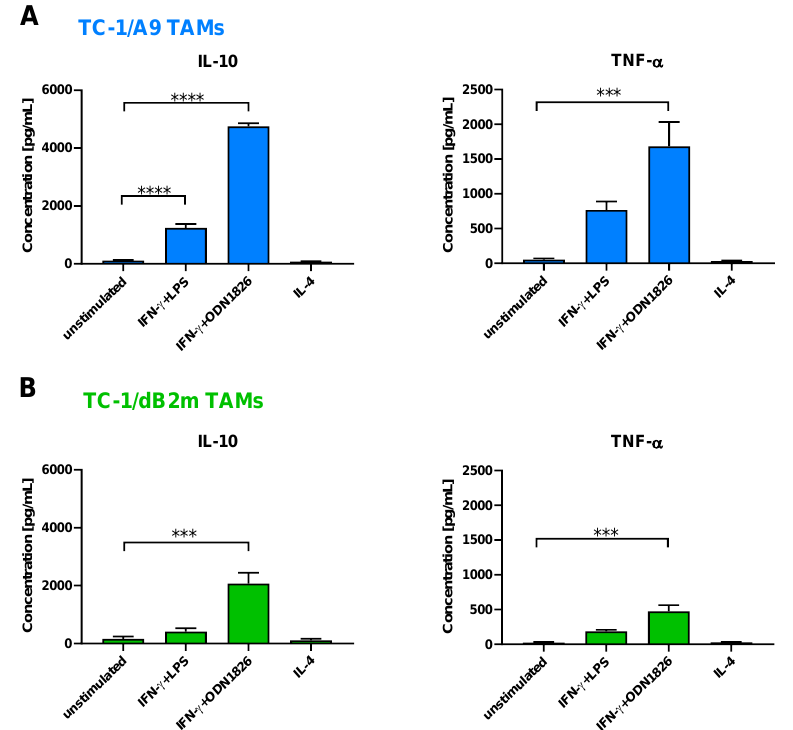
Figure 5. In Vitro production of cytokines by stimulated TAMs. TAMs from TC-1/A9 ( A ) or TC-1/dB2m tumors ( B ) were isolated and stimulated with IFN- γ + TLR agonist or IL-4 for 44 h. Subsequently, the cell culture supernatants were collected and used for the measurement of IL-10, IL-12p70, and TNF- α concentrations by ELISA. The unstimulated cells were used as a negative control. Columns indicate mean of three independent experiments; bars: ± SEM; *** p < 0.001, **** p < 0.0001.